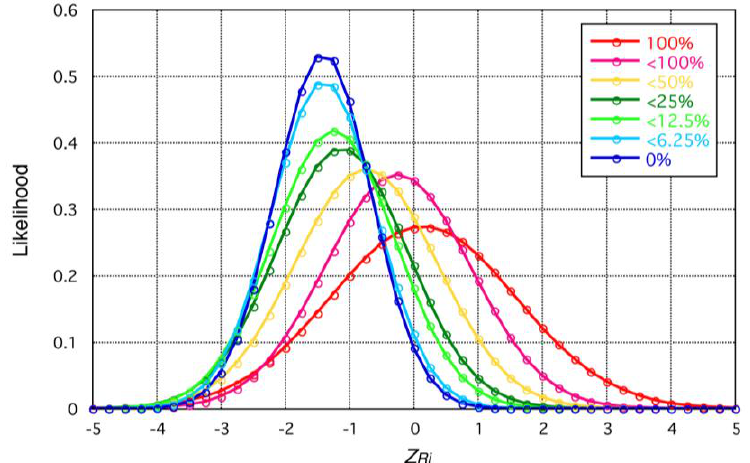
Table 2. Average values and standard deviations of likelihood function of SAR intensity image information.